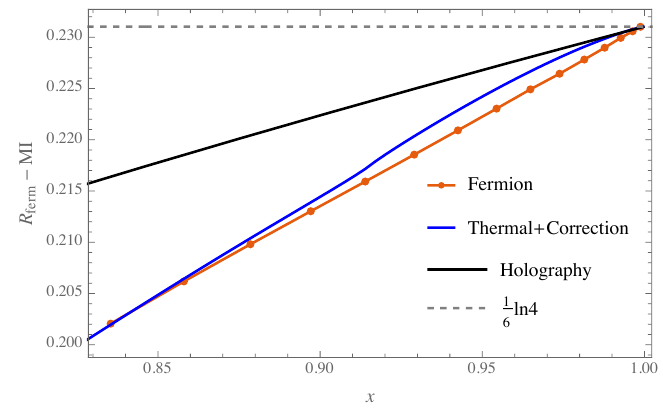
Figure 6 . The Markov gap S R − MI of the analytics versus results obtained from numerics at large conformal cross-ratio x . The analytical prediction is based on the leading order thermal prediction (4.21), plus the corrections (4.56) obtained in this subsection. This figure is the magnified version of figure 1 at x → 1